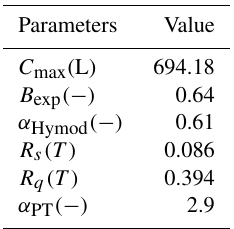
Table 3. Optimized parameters obtained from daily ADIGE simu- lation during the calibration period (1994–1999). Parameters’ phys- ical meaning is explained in Appendix A. The last parameter is for the ET